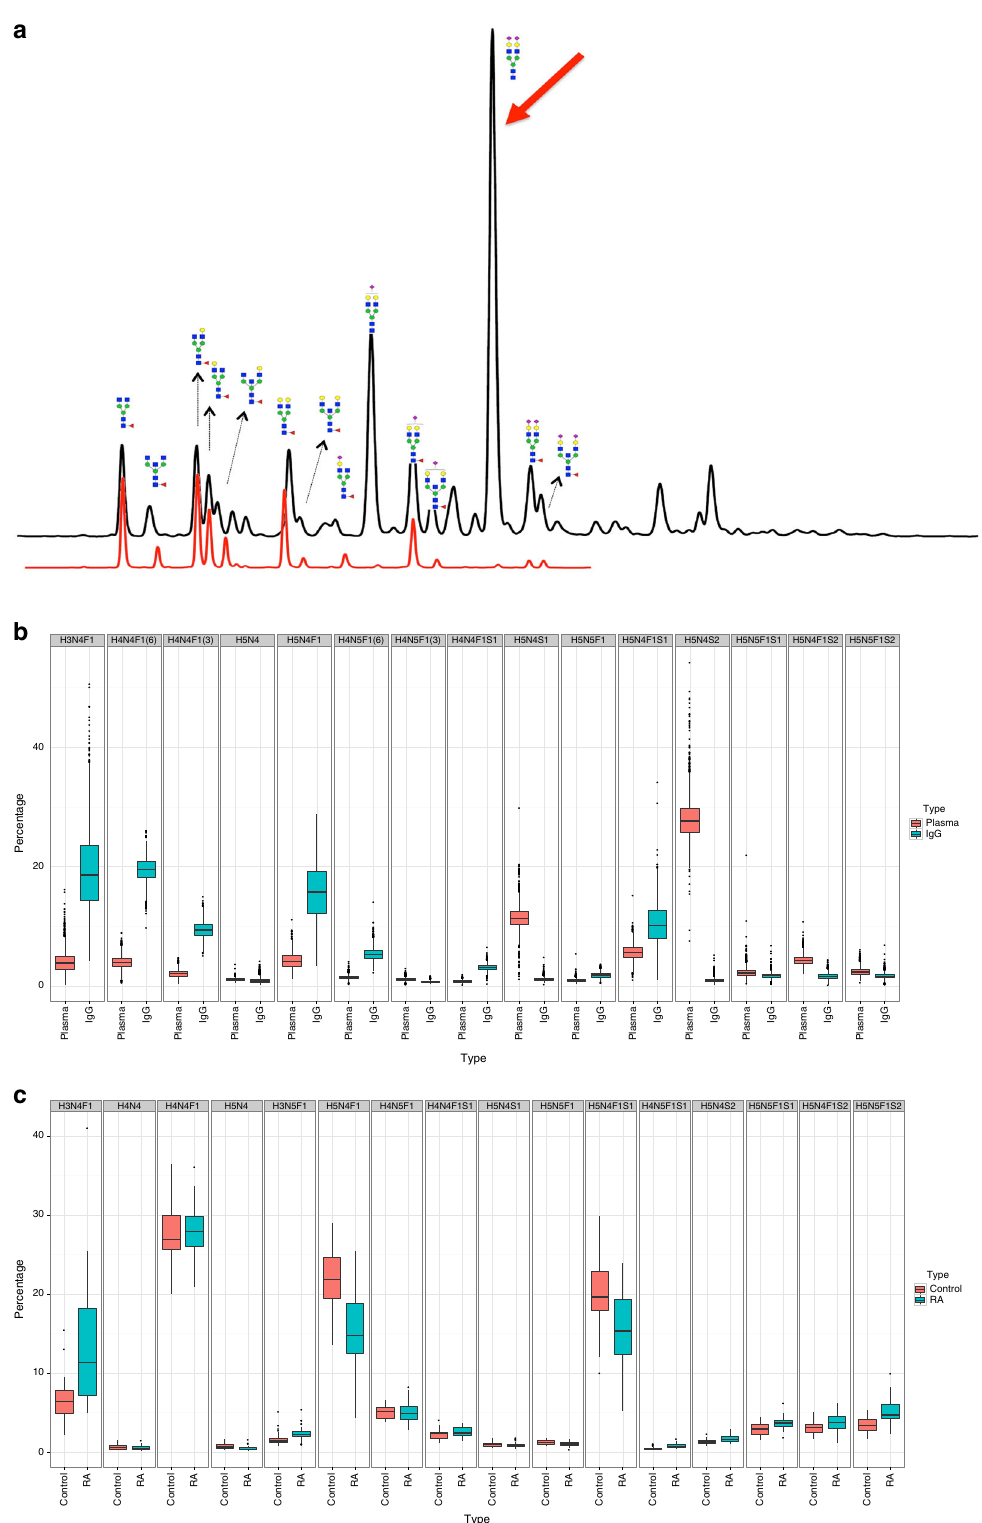
Fig. 1 IgG and total plasma N-glycomes. a An overlay of UHPLC traces of IgG (red) and total plasma (black) glycomes. Major structures that are present in both total plasma and IgG glycomes are presented as cartoons composed of N- acetylglucosamine (blue square), mannose (green circle), galactose (yellow circle), fucose (red triangle) and sialic acid (purple diamond). The red arrow marks the largest plasma glycan peak that contains the diantennary, digalactosylated and disialylated glycan without core fucose (H5N4S2). This structure is present only in trace amounts in the total IgG glycome pool and is completely undetectable as a corresponding Fc glycopeptide 3,11,12 . b Composition of the total plasma and IgG N-glycomes in 2611 individuals from the general population analysed by UHPLC 5 . c Comparison of major IgG glycan structures in 31 patients with RA and 25 age-matched healthy individuals measured by MALDI-TOF-MS